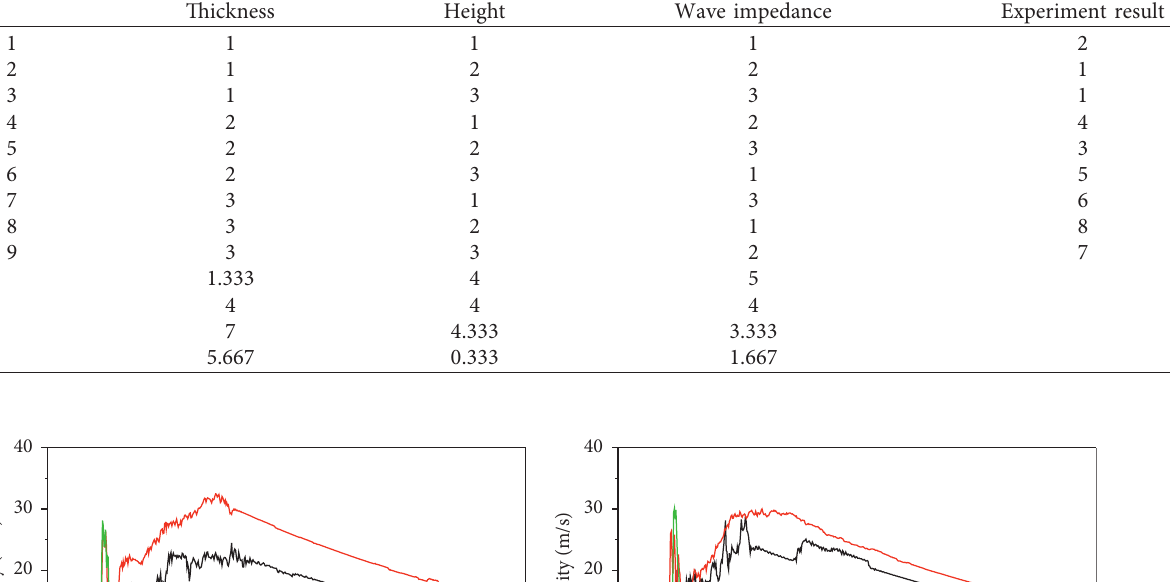
Table 7: Orthogonal experiment